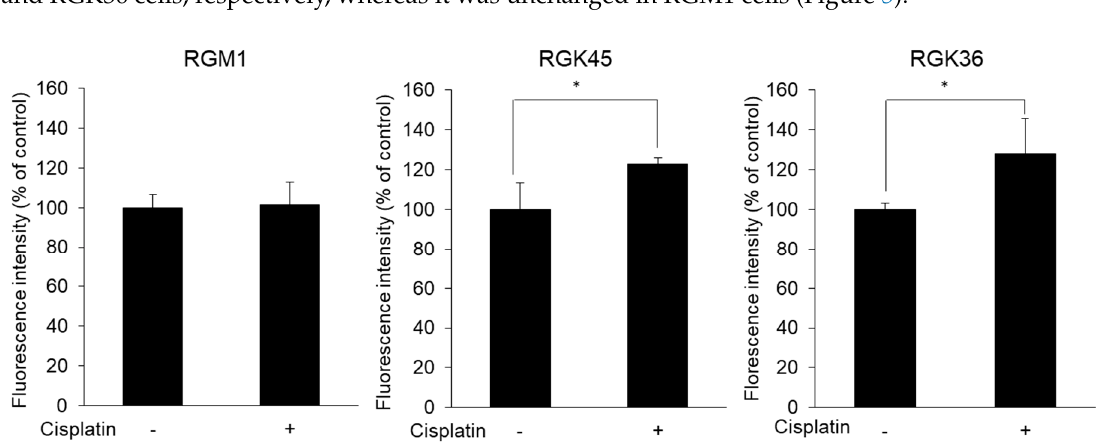
Figure 5. Porphyrin accumulation in each cell after 5-aminolevulinic acid (ALA) exposure (1 mM). Porphyrin fluorescence intensity derived ALA increased by cisplatin treatment (10 μ M) in RGK45 and RGK36 cells. Data are expressed as means ± SD (n = 4). * p < 0.05.